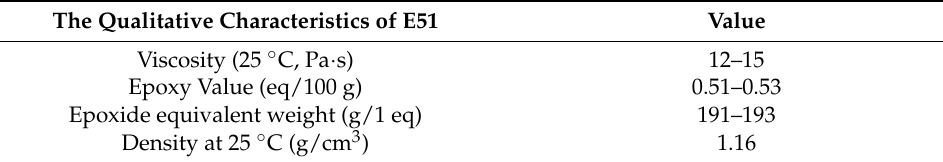
Table 1. Properties of epoxy resin E51.